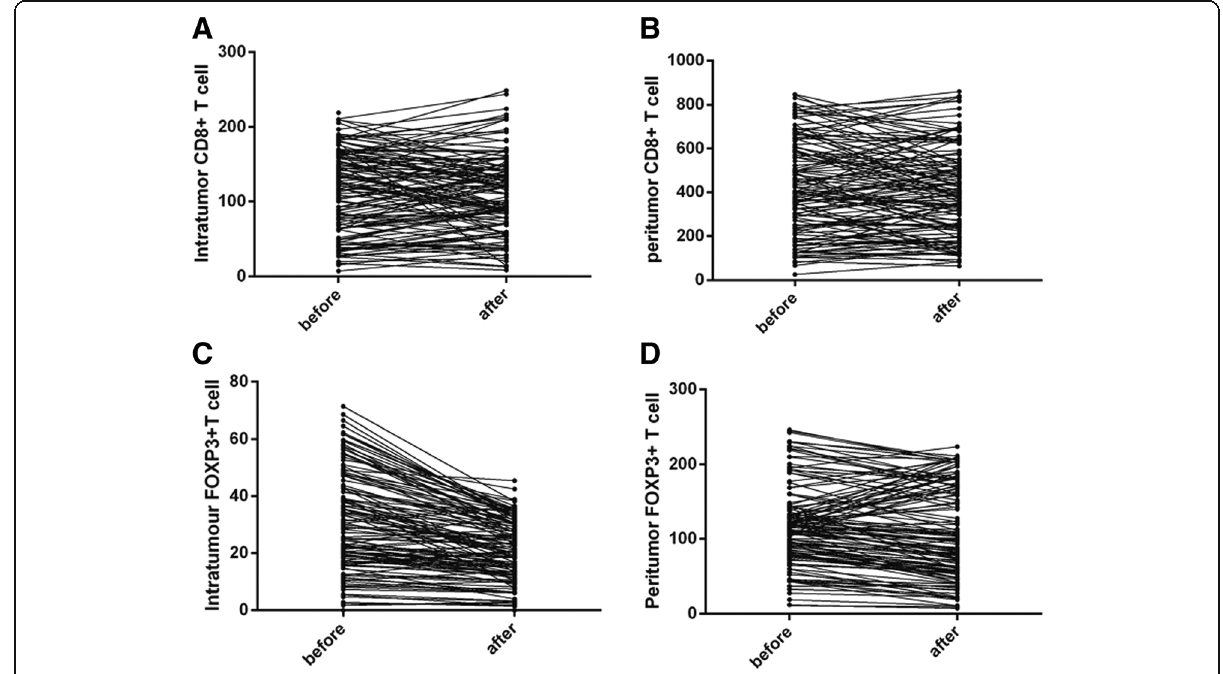
Fig. 2 The change of CD8+ and Foxp3+ T cells in cervical cancer after NACT. CD8+ T cells did not significantly change in either intratumoral ( a ) or peritumoral ( b ) areas whereas the infiltration of Foxp3+ T cells significantly decreased in both intratumoral ( c ) and peritumoral